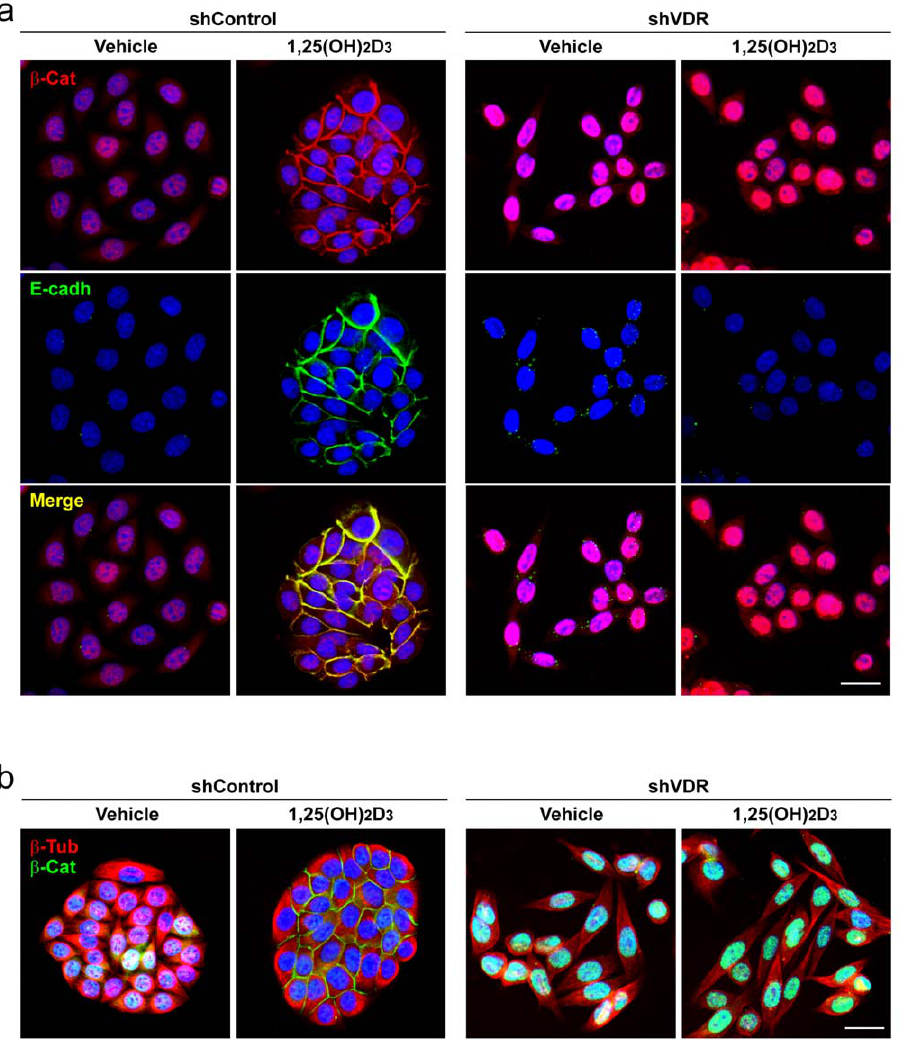
Figure 3. VDR knock-down in SW480-ADH human colon cancer cells increases b -catenin nuclear level. Representative immunofluorescence images showing b -catenin and E-cadherin (a) or b -catenin and b -tubulin (b) expression and localization in SW480-ADH cells infected with lentiviruses expressing shVDR or shControl and treated with 1,25(OH) 2 D 3 or vehicle for 72 h. Scale bar, 20 m m.